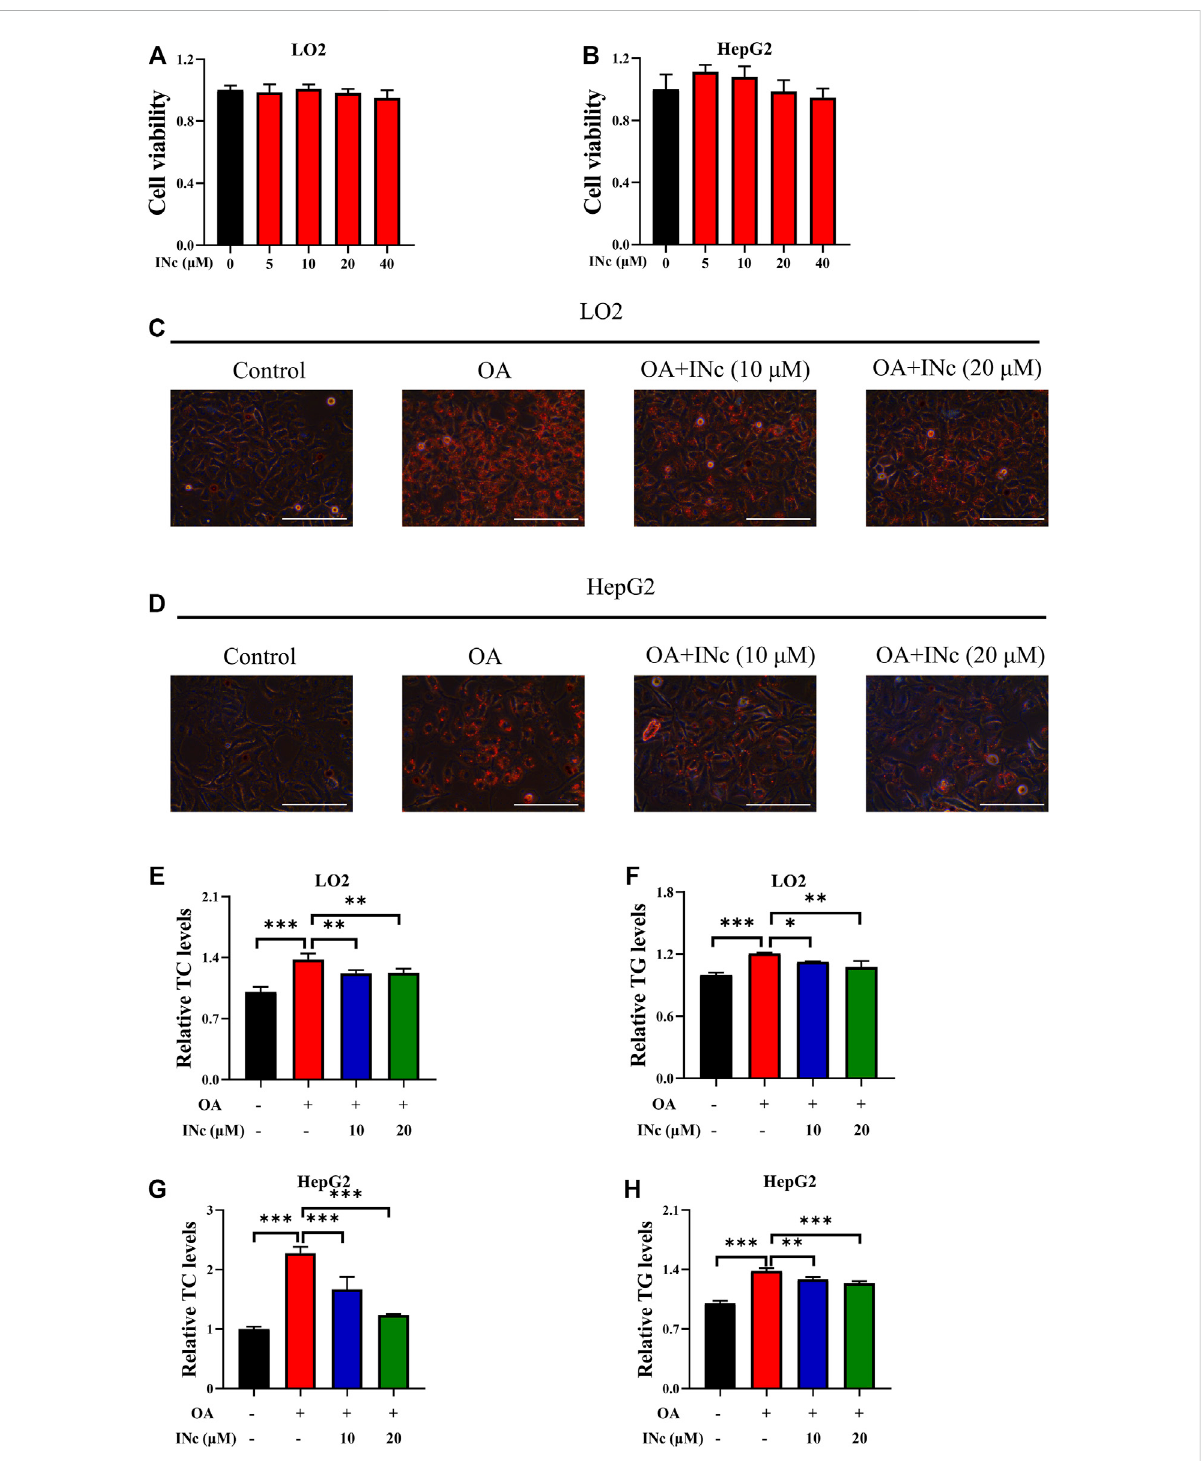
FIGURE 2 BCATc Inhibition alleviates OA-induced hepatic steatosis. (A,B) LO2 and HepG2 cells were incubated with indicated concentrations of BCATc Inhibitor 2 for 48 h and MTT assay was performed. (C – H) LO2 and HepG2 cells were incubated with 0.5 mm Oleic acid and 0, 10, 20 µM BCATc Inhibitor 2for 48 h.Intracellular lipid dropletswere detectedby Oilred Ostaining.Scale bar =400 μ M (C,D) . Intracellular TCand TGlevels in LO2 (E, F) and HepG2 (G – H) cells were detected. Data are shown as the mean ± SD of three independent experiments. * p < 0.05, ** p < 0.01, *** p < 0.001. INc: BCATc Inhibitor